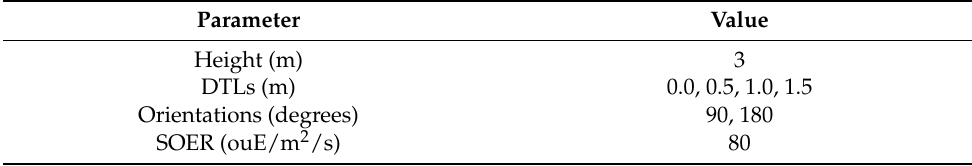
Table 3. Common characteristics of the fictitious